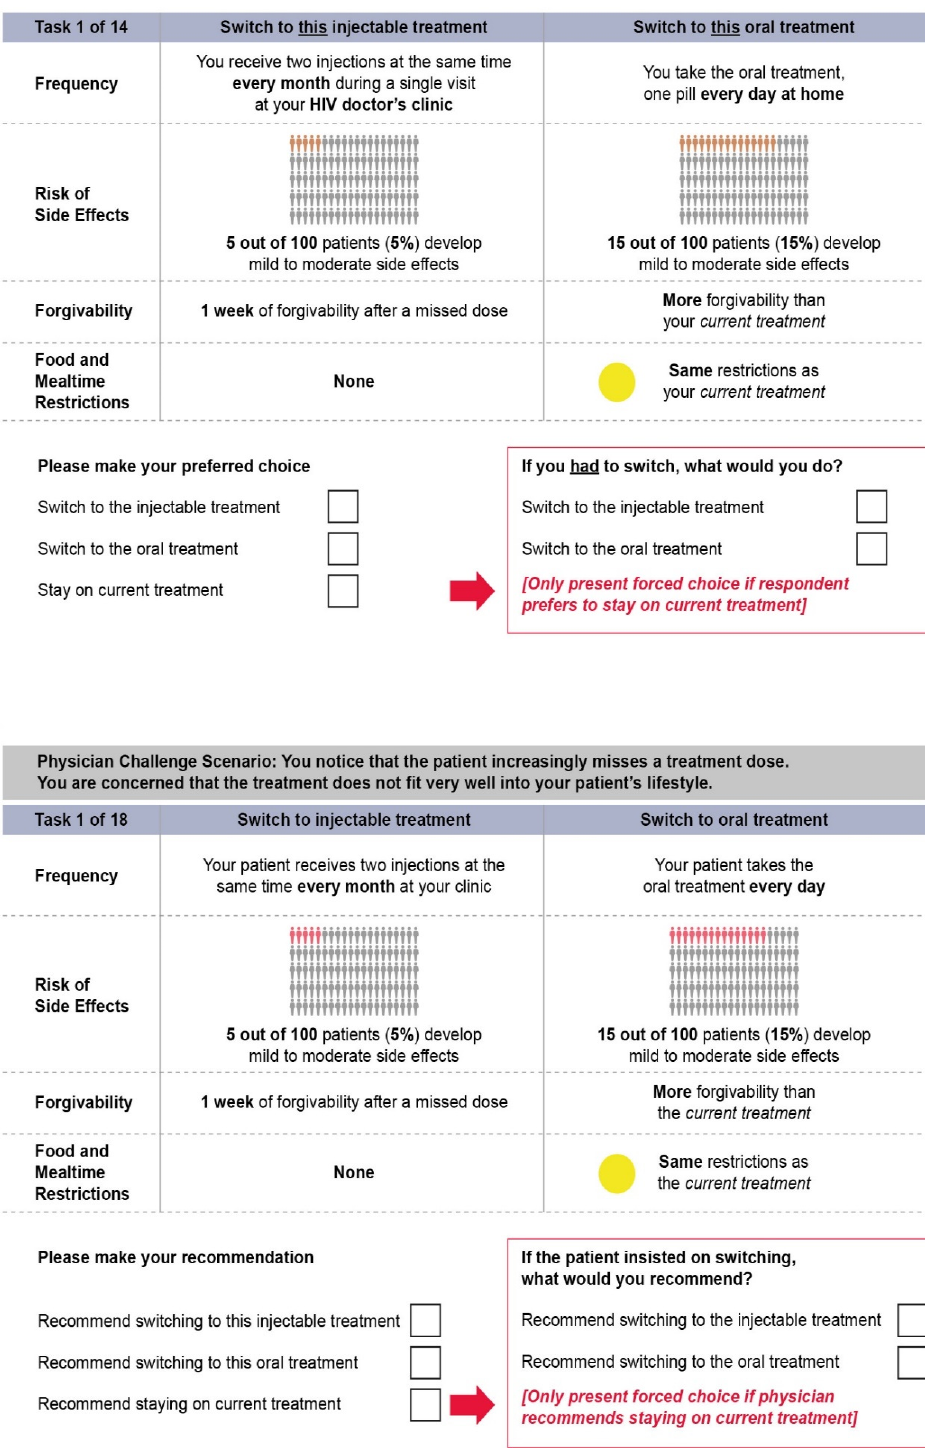
Figure 1. ( a ) Example PLWH choice task and ( b ) example physician choice task. If PLWH or physicians chose to stay on their current treatment or recommend that PLWH remain on current treatment, they were prompted with a forced choice task asking them to choose between switching to the LAI or oral treatment, shown in the red box. HIV = human immunodeficiency virus; PLWH = people living with